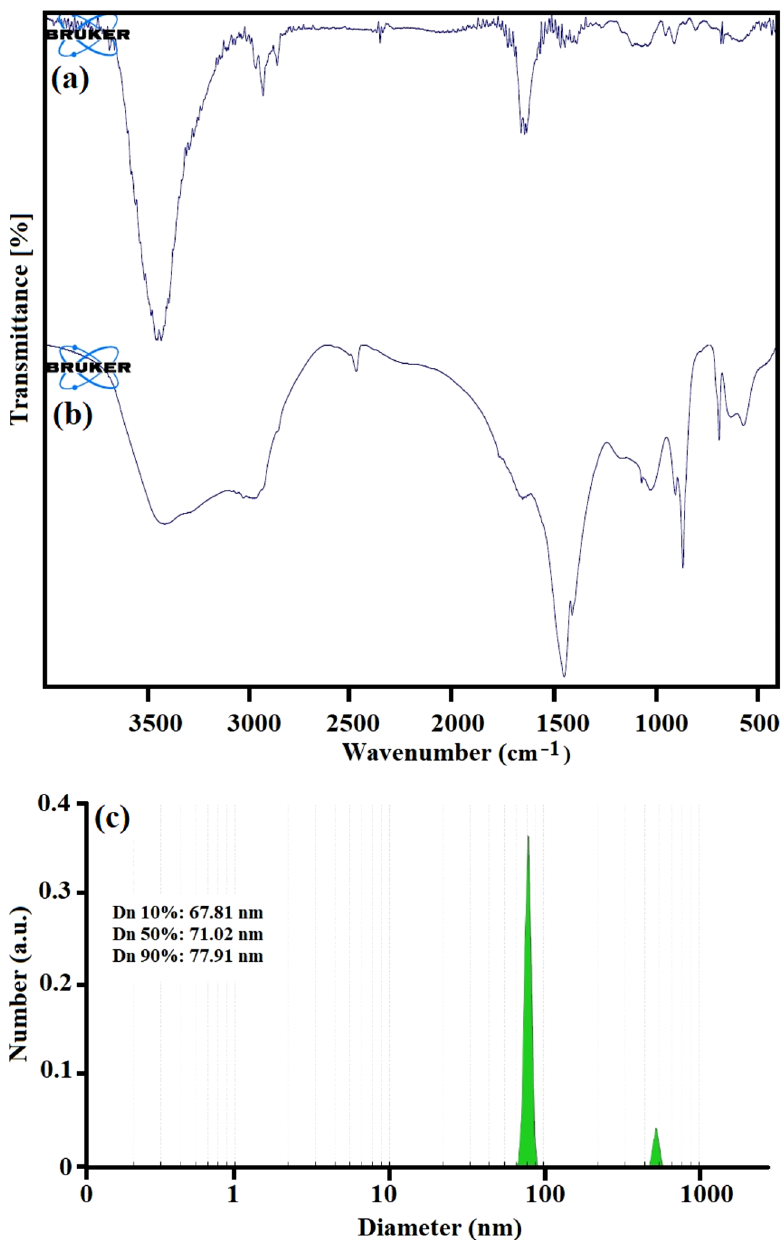
Figure 2. The FT-IR spectroscopy of the niosomal formulation ( a ), the niosomal formulation contain crocin ( b ) and DLS